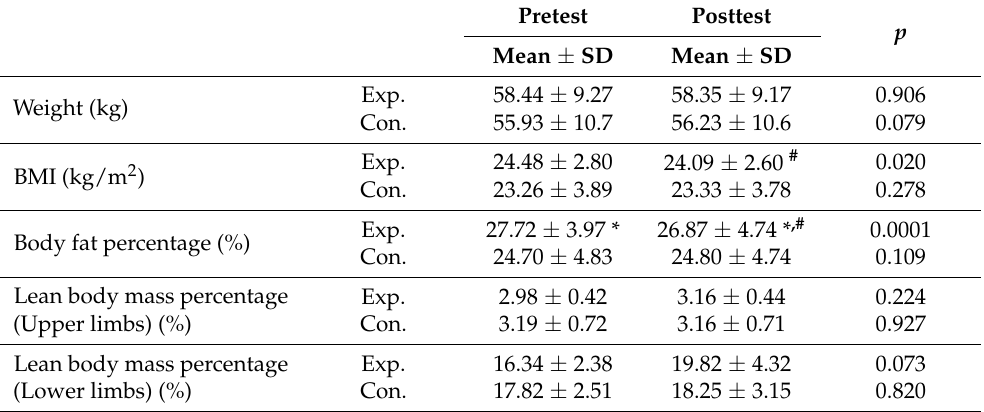
Table 4. Effects of 12-week Pilates on body